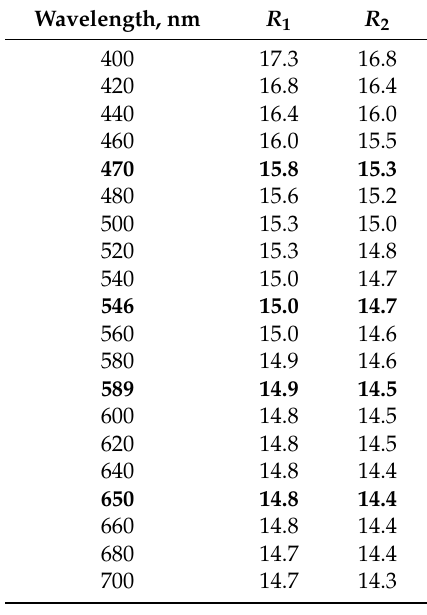
Table 2. Reflectance values ( R max / R min ) for nöggerathite-(Ce). Reflectance values for four wavelengths recommended by the Commission on Ore Microscopy of the International Mineralogical Association are given in bold type.